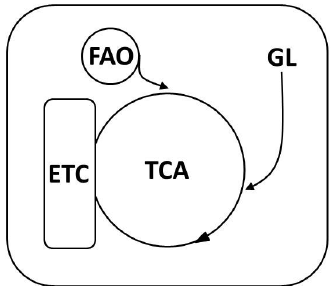
Figure 5. Molecular pathways associated with CVD etiology. Contributing CVD factors, such as diabetes, cause an imbalance of essential physiological pathways by impairing normal glycolysis (GL), which feeds into the tricarboxylic acid pathway (TCA) that is directly linked to the electron transport chain (ETC). Fatty acids, which can also contribute and feed into the TCA cycle through fatty acid oxidation (FAO), are also implicated in CVD manifestation. Multiple enzymes involved in this scheme have been shown to either modulate or directly generate